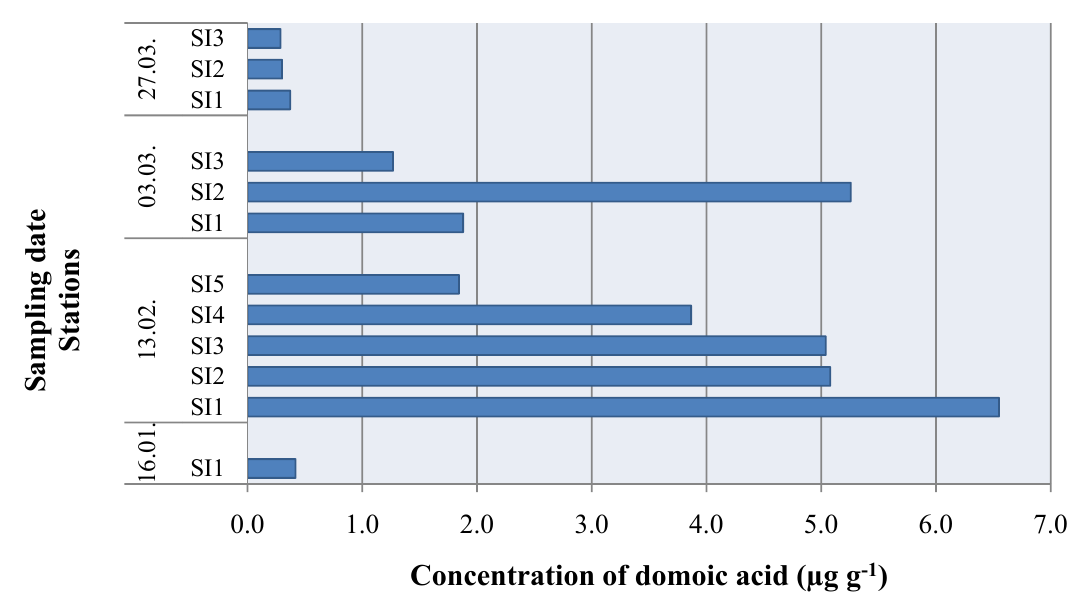
Figure 2. Domoic acid in shellfish samples ( Mytilus galloprovincialis ) from the central Adriatic Sea in 2006 (see Figure